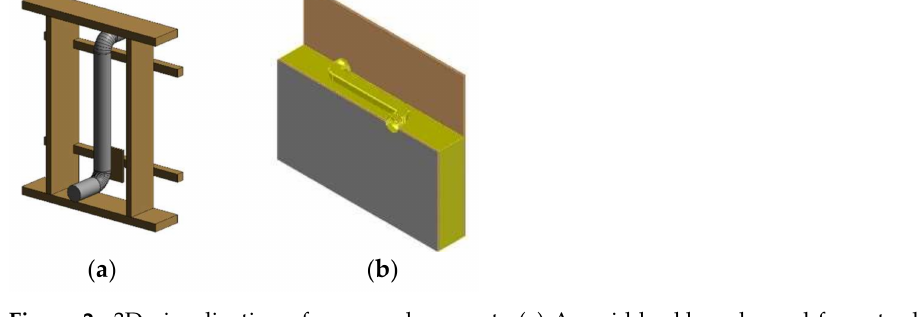
Figure 2. 3D visualization of proposed concept. ( a ) Aramid backboard panel for extra ballistic protection; ( b ) External balistic